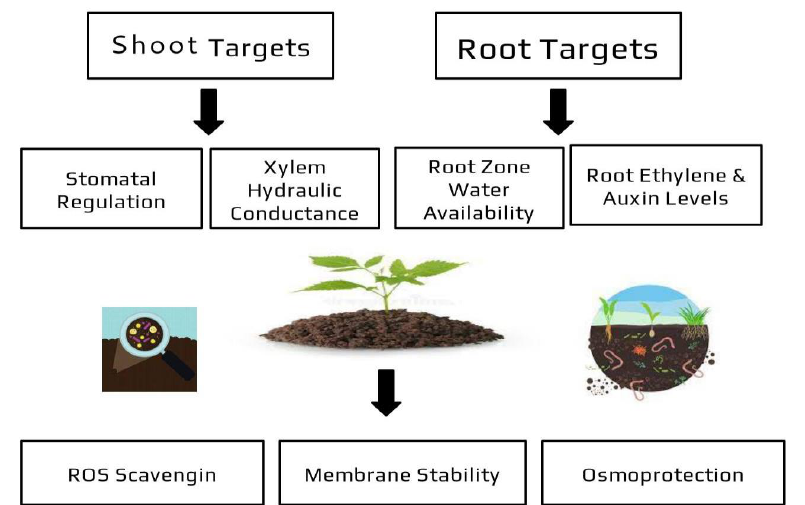
Figure 1. The principal mechanisms targeted by microorganisms based of different biostimulants.